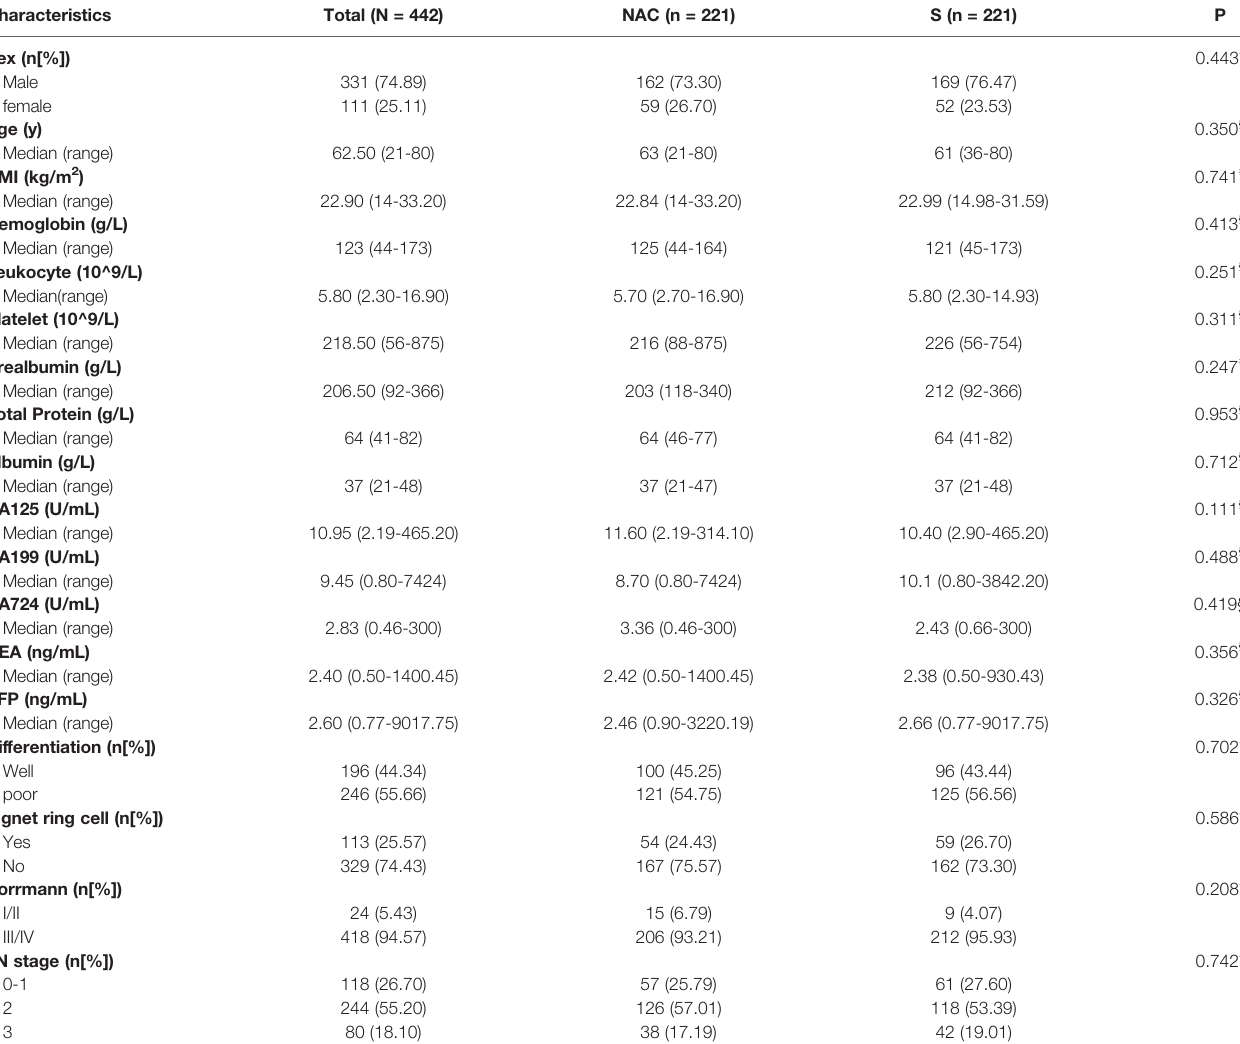
TABLE 2 | Pre-treatment clinical characteristics of LAGC (cT4NxM0) patients after 1:1 matched. Characteristics